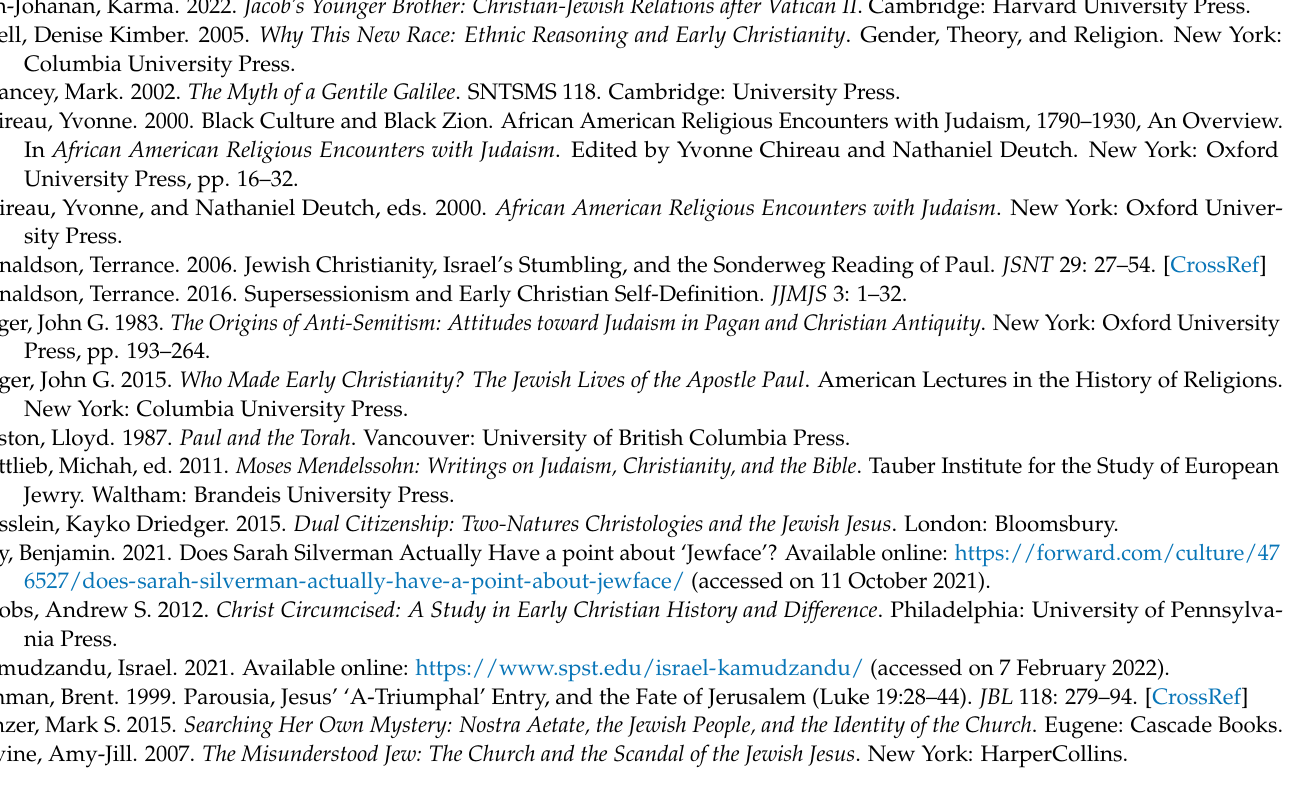
Table. Available online: https://www.resourceumc.org/en/content/remembering-the-mission-during-disagreements (accessed on 21 December